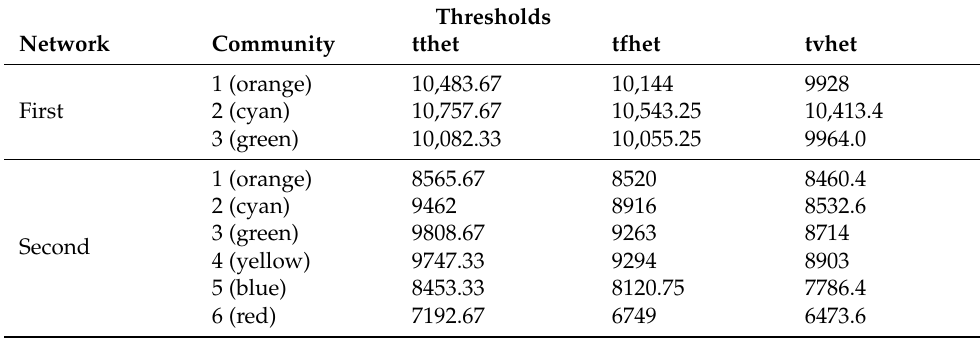
Table 6. Threshlods for each community of the first and second